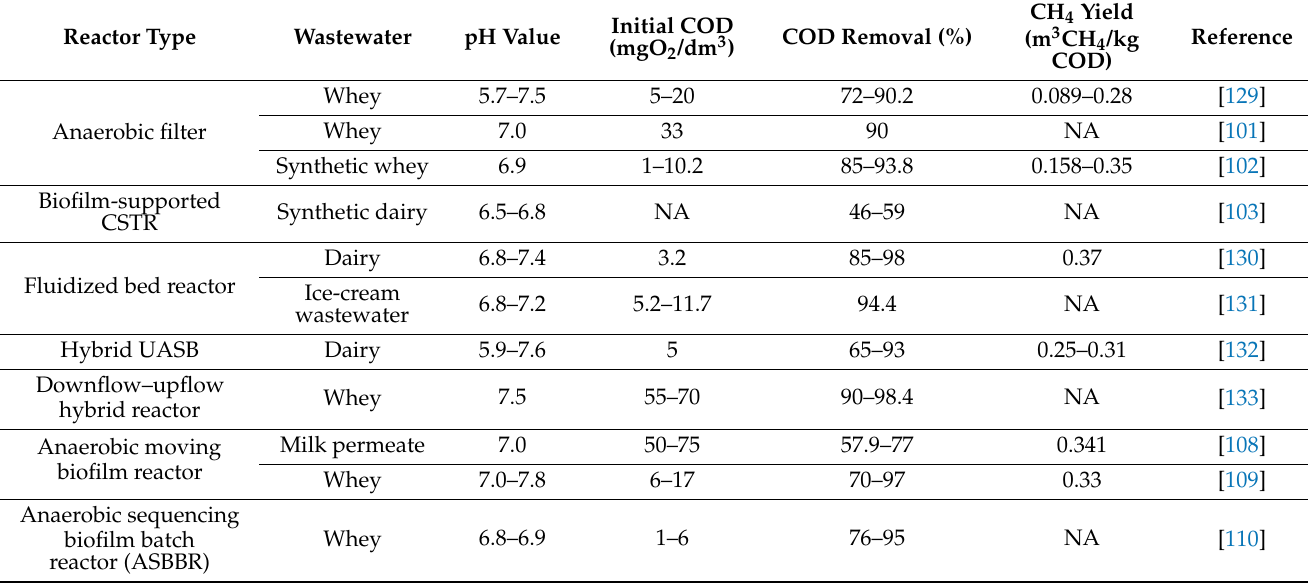
Table 5. Digestion performance vs. wastewater